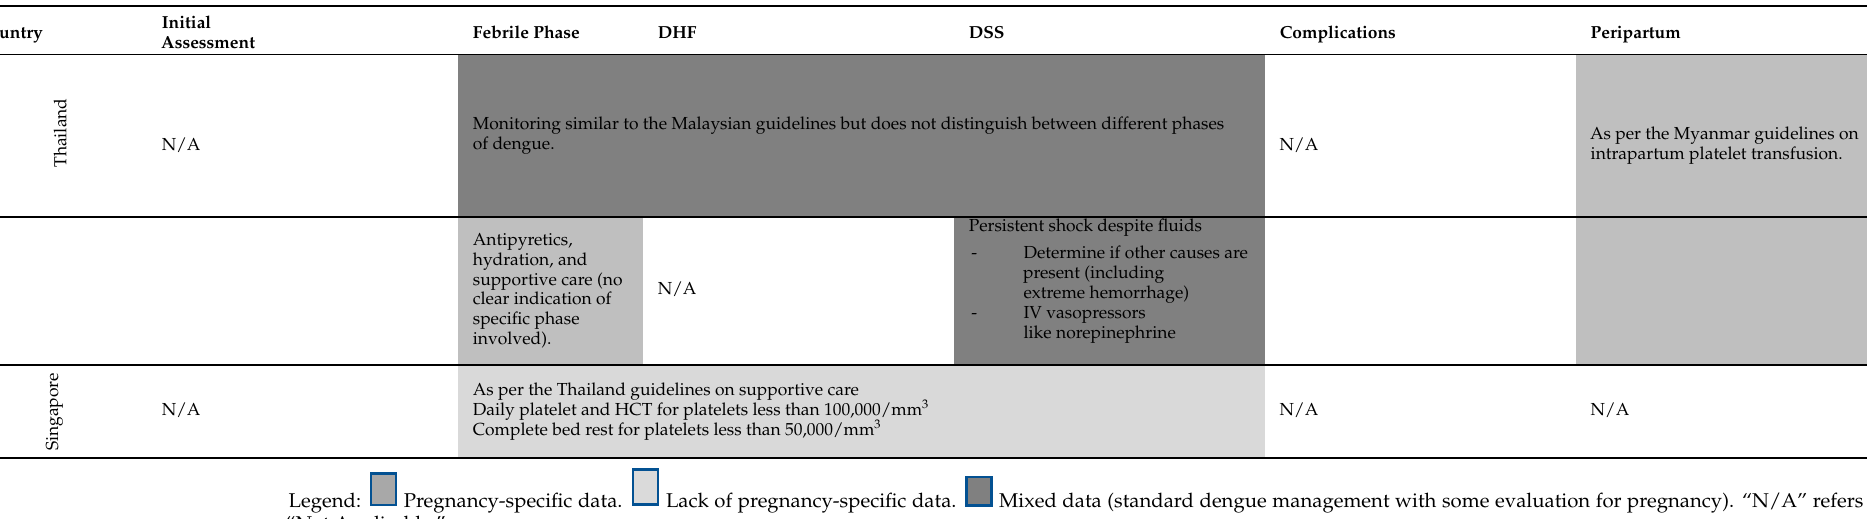
Mixed data Mixed